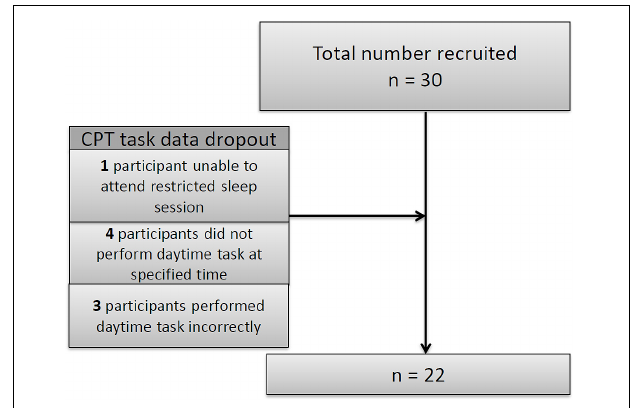
FIGURE 2 | Flow diagram of recruitment